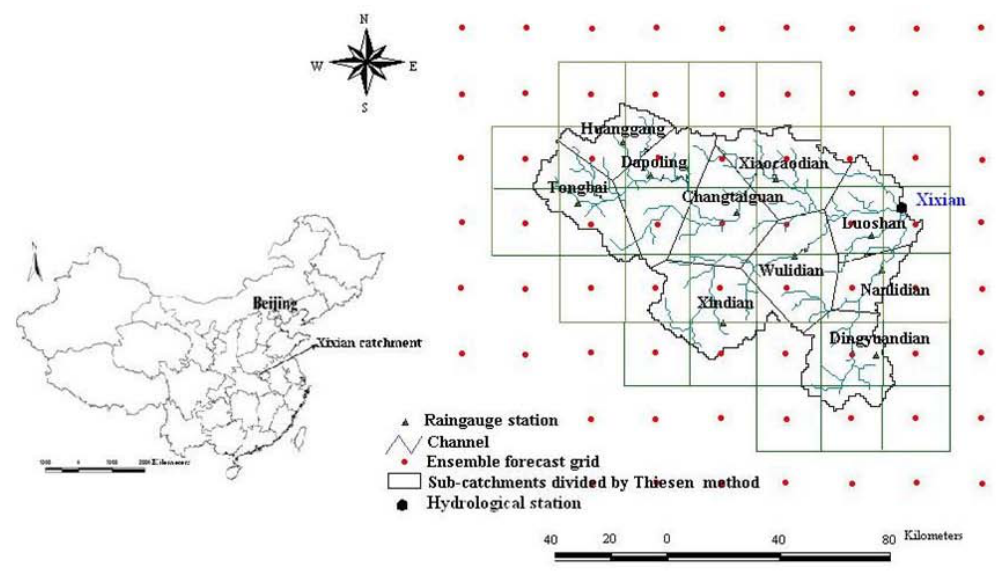
Fig. 1. The location of Xixian catchment in China (left), and the Xixian catchment (right).